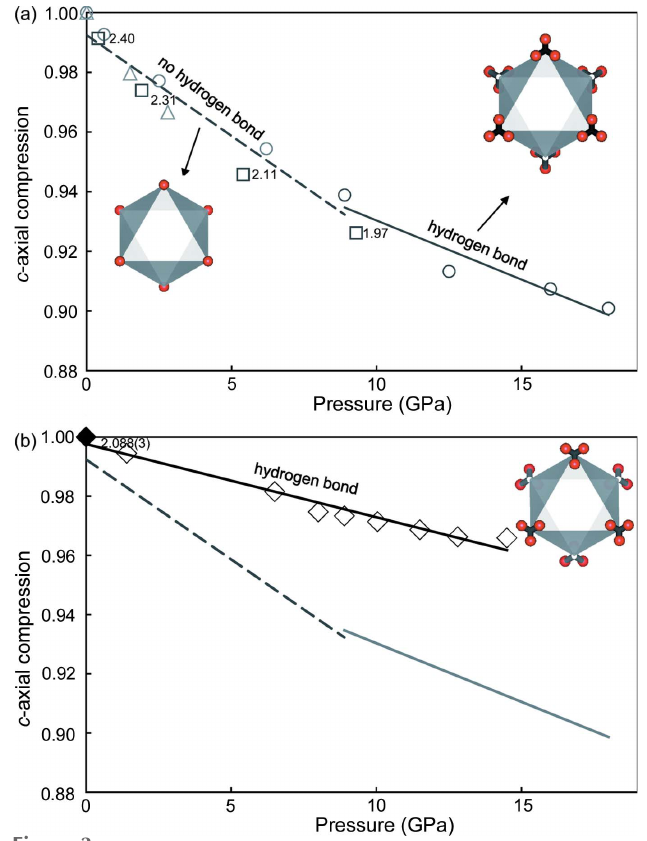
Figure 3 Compressibility along the c axis ( c / c 0 ) of brucite and DHMS phase E. ( a ) c / c 0 of brucite reported by Nagai et al. , 2000 (circles); Okuchi et al. , 2014 (triangles); and Parise et al. , 1994 (squares). The solid and broken lines are linear fits of these data points at lower and higher pressures, respectively. The inset numbers show the distance D (cid:5)(cid:5)(cid:5) O across the interlayer space at room temperature, obtained from Okuchi et al. (2014), and Parise et al. (1994). The distance monotonically decreases with increasing pressure to form a hydrogen bonding interlayer, which makes the structure distinctly harder. The inset figures show the D sites of brucite at ambient and high pressures, respectively. ( b ) c / c 0 of DHMS phase E reported by Shieh et al. , 2000 (diamonds). The c axis of DHMS phase E around ambient pressure is already less compressible than that of brucite at high pressures. The inset number shows the distance D (cid:5)(cid:5)(cid:5) O, determined in present study. The inset figure shows the D sites of DHMS phase